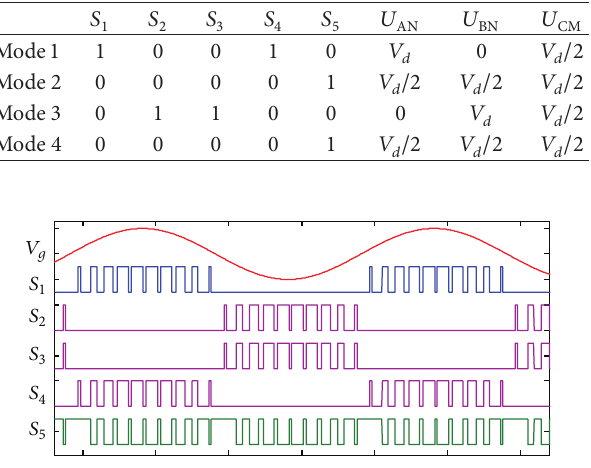
Figure 3: Switching state of the proposed